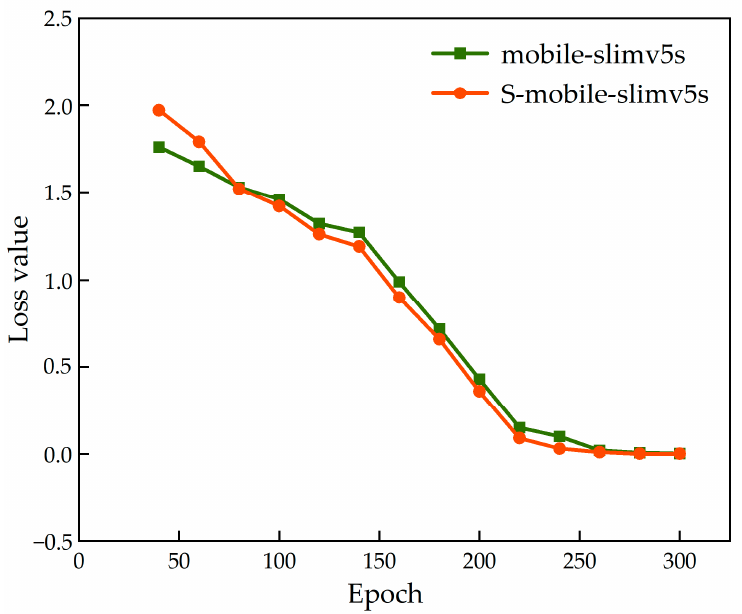
Table 6. Performance comparison of models when the input dataset is Dataset(S).